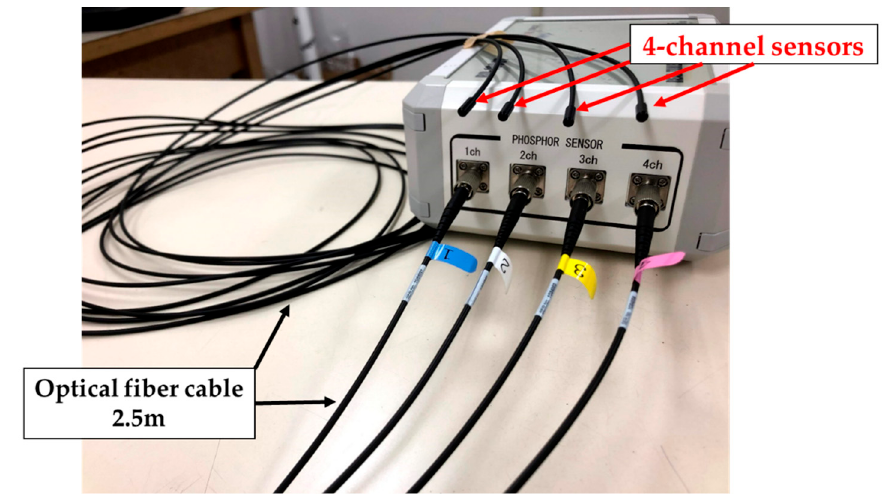
Figure 3. Apparent condition of novel real-time radiation system using 4-channel sensors.